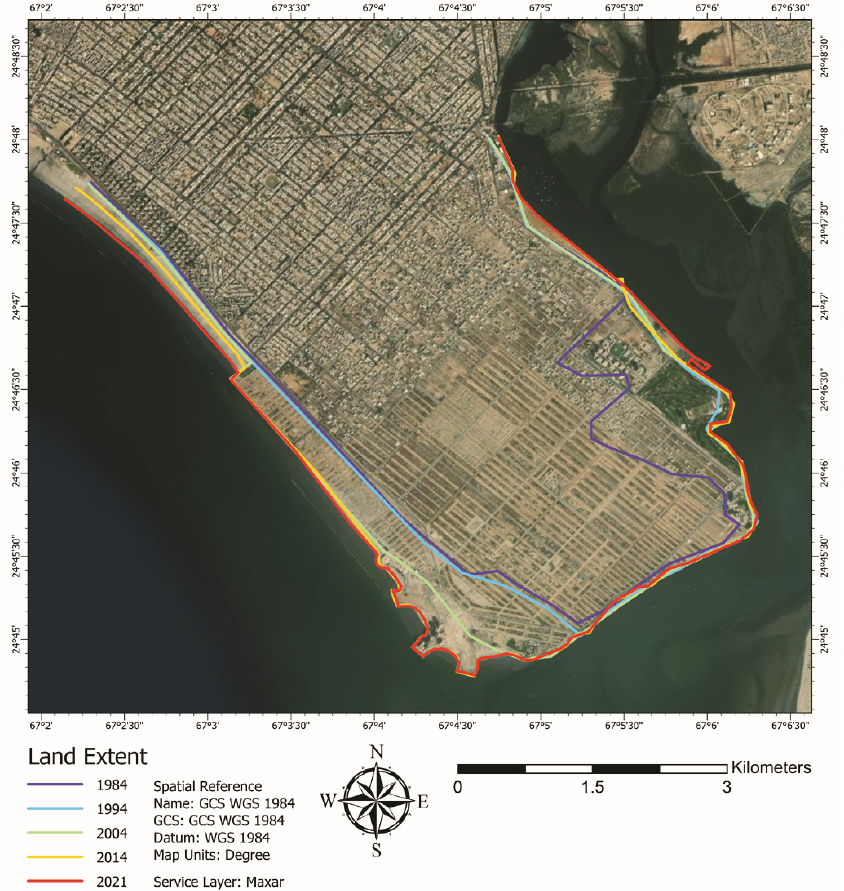
Figure 10. Extent of Defence landmass over time traced from historical Google Earth imagery.